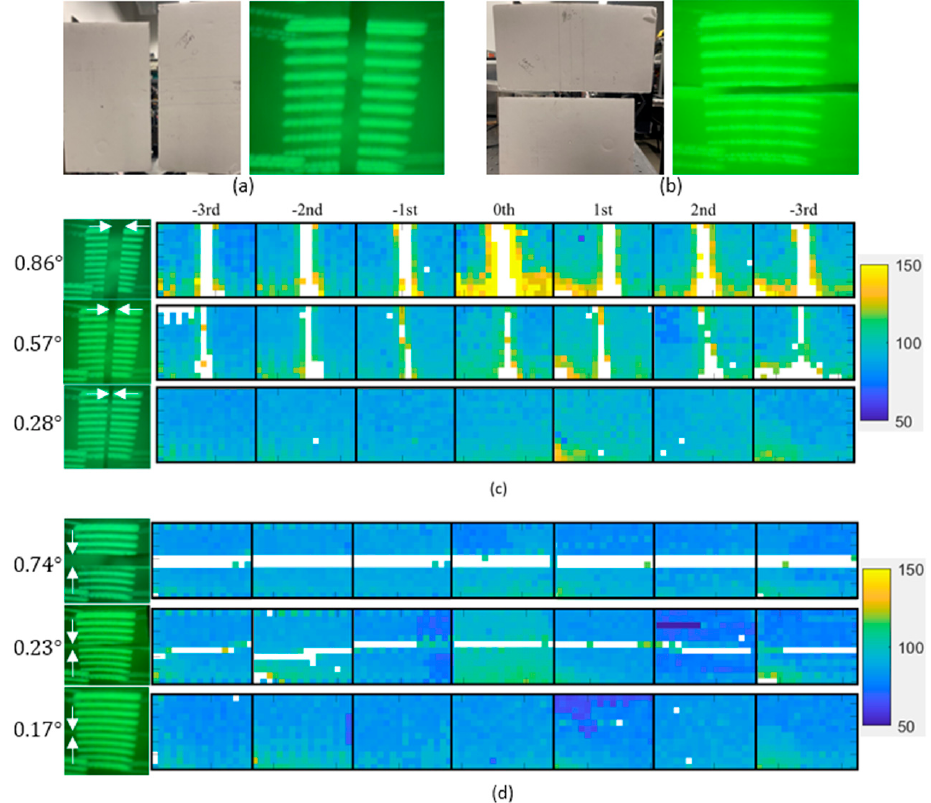
Figure 11. ( a ) Vertical slit placed at a single diffraction order and corresponding beam pattern on the target. ( b ) Horizontal slit placed at a single diffraction order and corresponding beam pattern on the target. ( c ) Lidar image corresponding to the vertical slit target depicted in ( a ). ( d ) Lidar image corresponding to the horizontal slit target depicted in ( b ).